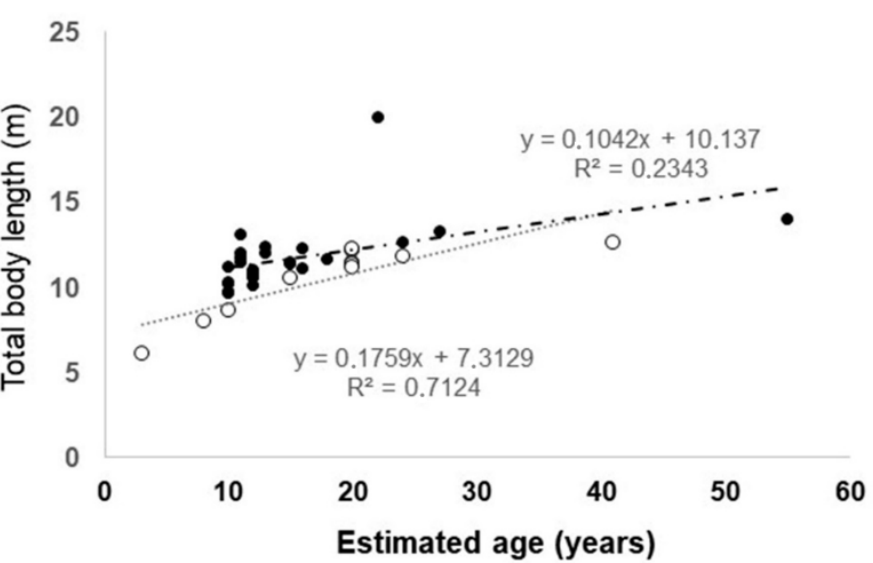
Figure 2. Relationship between age and total body length in Mediterranean (open circle) and At- lantic (filled circle) male sperm whales. Linear regression equations are also showed. (filled circle) male sperm whales. Linear regression equations are also